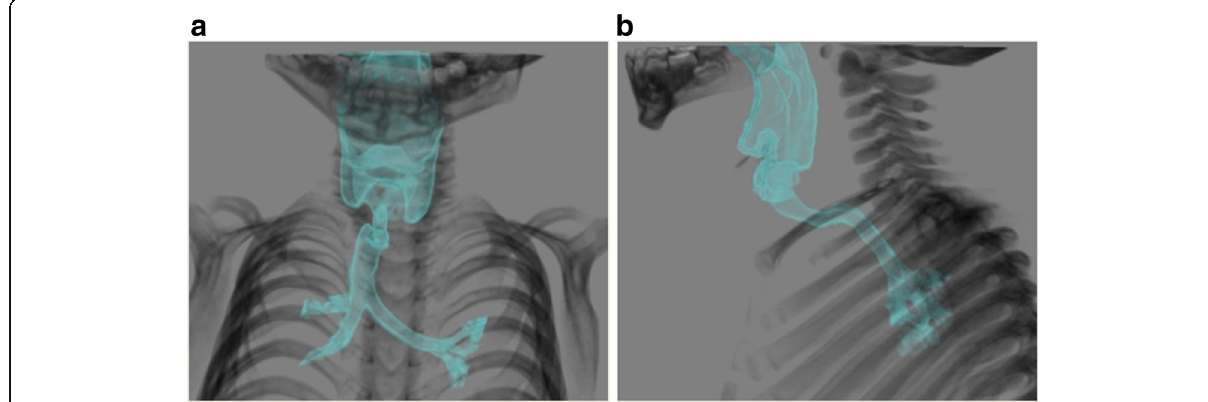
Fig. 1 Computed tomography before operation. a Frontal view. b Lateral view. The trachea was severely deviated at an angle of 90 ° from the ventral to dorsal